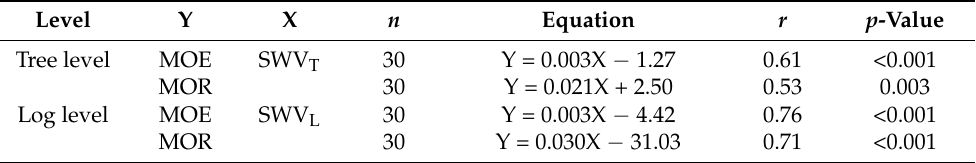
Table 6. Correlations of stress wave velocity measured in standing trees and logs with static bending properties (MOE and MOR) for six Eucalyptus clones planted in Vietnam.